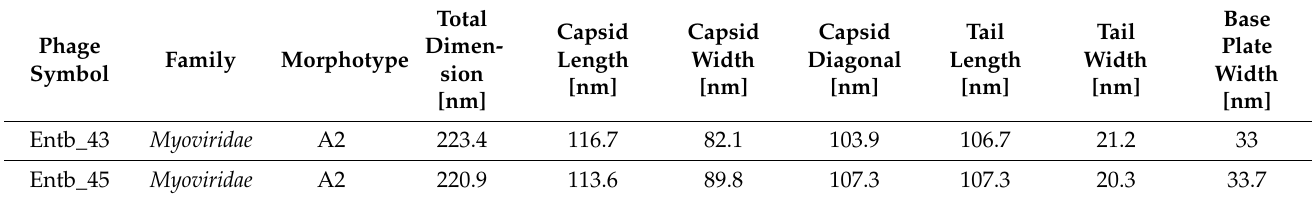
Table 4. Dimensions of bacteriophages. Average measurements of ten virions are shown.